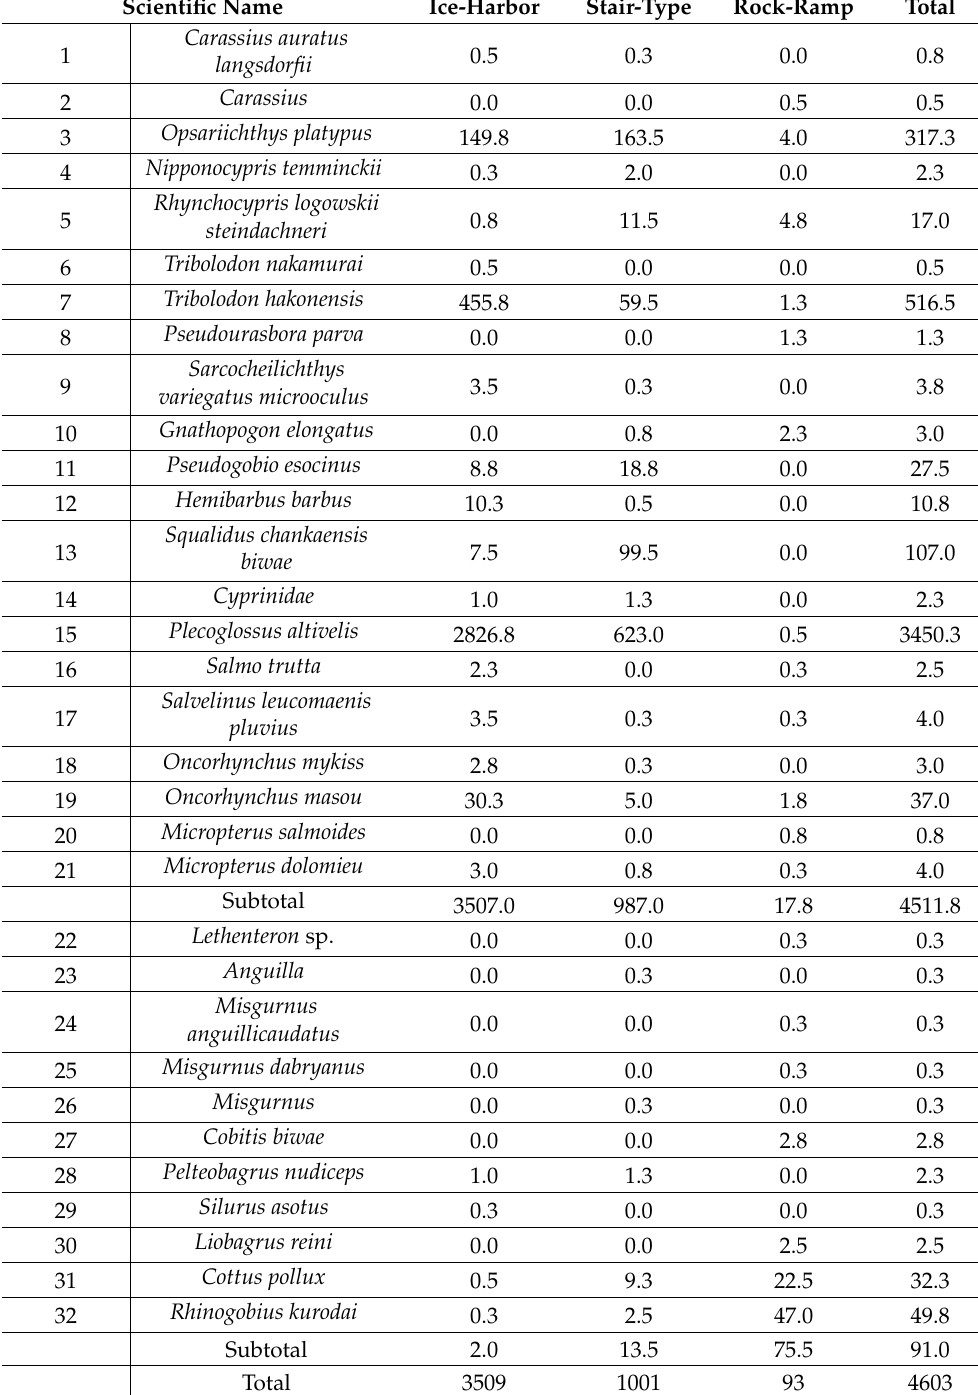
Table 5. Numbers of fish caught in S-1 of each fishway during the period of four years from 2012 to 2015. The numbers shown are annual averages, and 1–21 are not bottom-dwelling